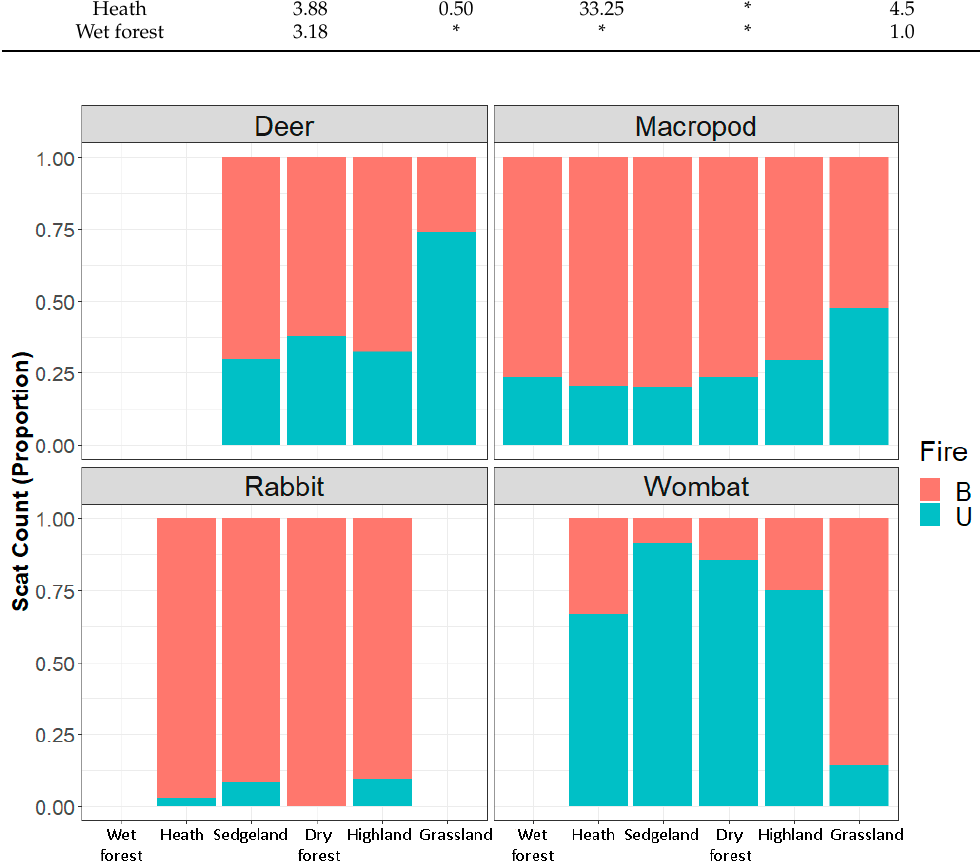
Figure 7. Proportional scat count recorded for each herbivore species ordered from least palatable vegetation cover (wet forest), to most palatable vegetation cover (grassland). Proportional abundance of scat count for burned sites in red, and unburned sites in blue.